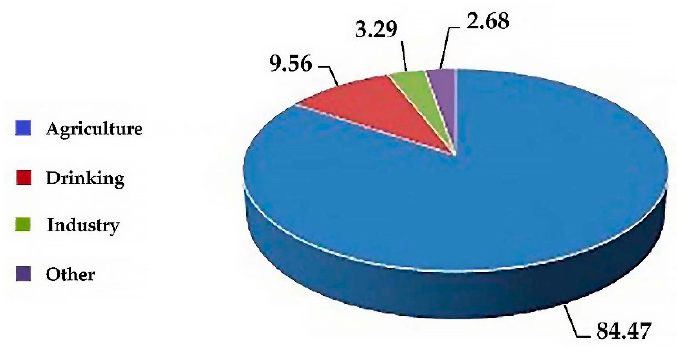
Figure 2. Percentage of groundwater use in different sections in South Khorasan province [33].